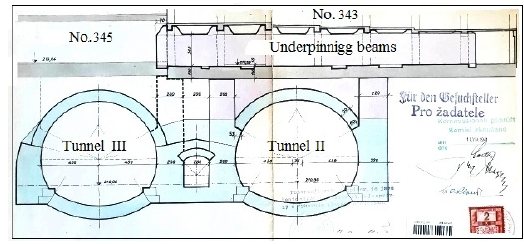
Figure 2. Diagram of underpinning the existing Above the Museum building No. 343 [1].